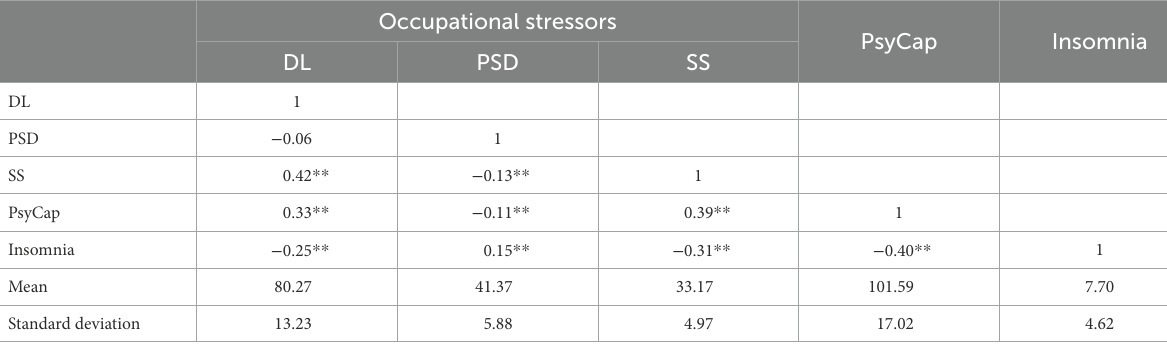
TABLE 2 Bivariate correlation